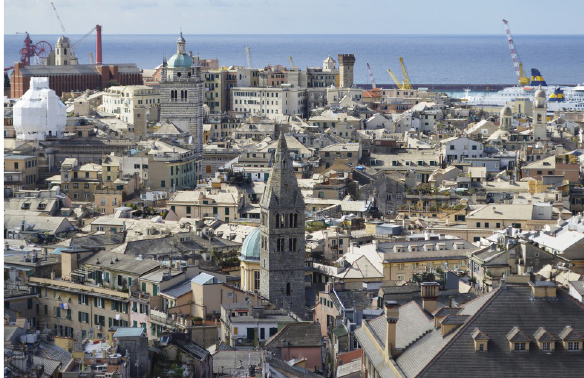
Figure 1. The Romanic bell tower, in the centre, within the dense Medieval town centre (A. Schiappapietra)